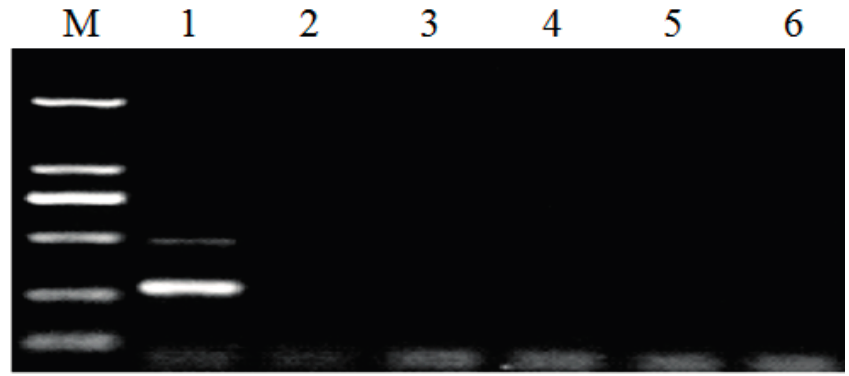
Figure A3. Specificity analysis of in-house nRT-PCR. M: DNA marker 2000 bp; 1: HEV positive control; 2: ddH 2 O as negative control; 3–6 are porcine reproductive and respiratory syndrome virus, hepatitis A virus, Norovirus and porcine epidemic diarrhea virus, respectively. This result indicated that the detection specificity of in-house nRT-PCR was acceptable, though the number of trials in current system is